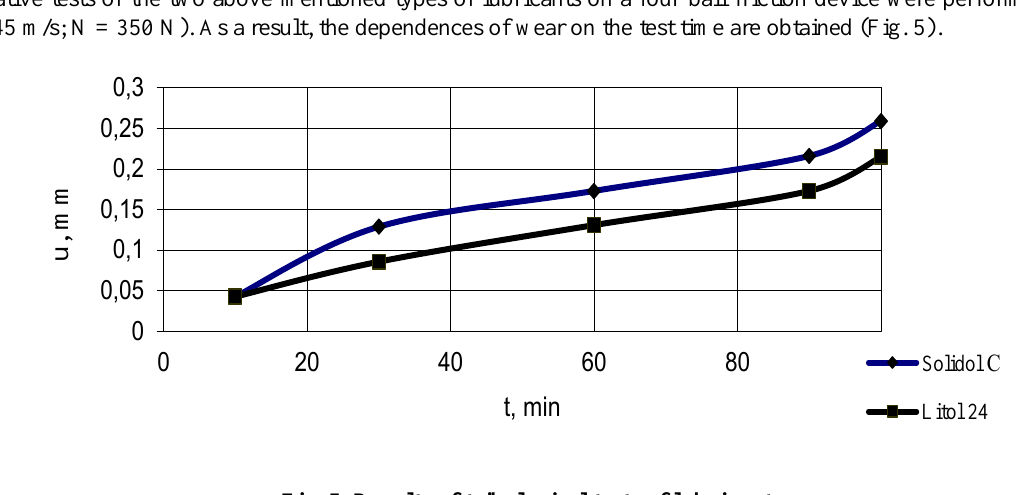
Fig. 5. Results of tribological tests of